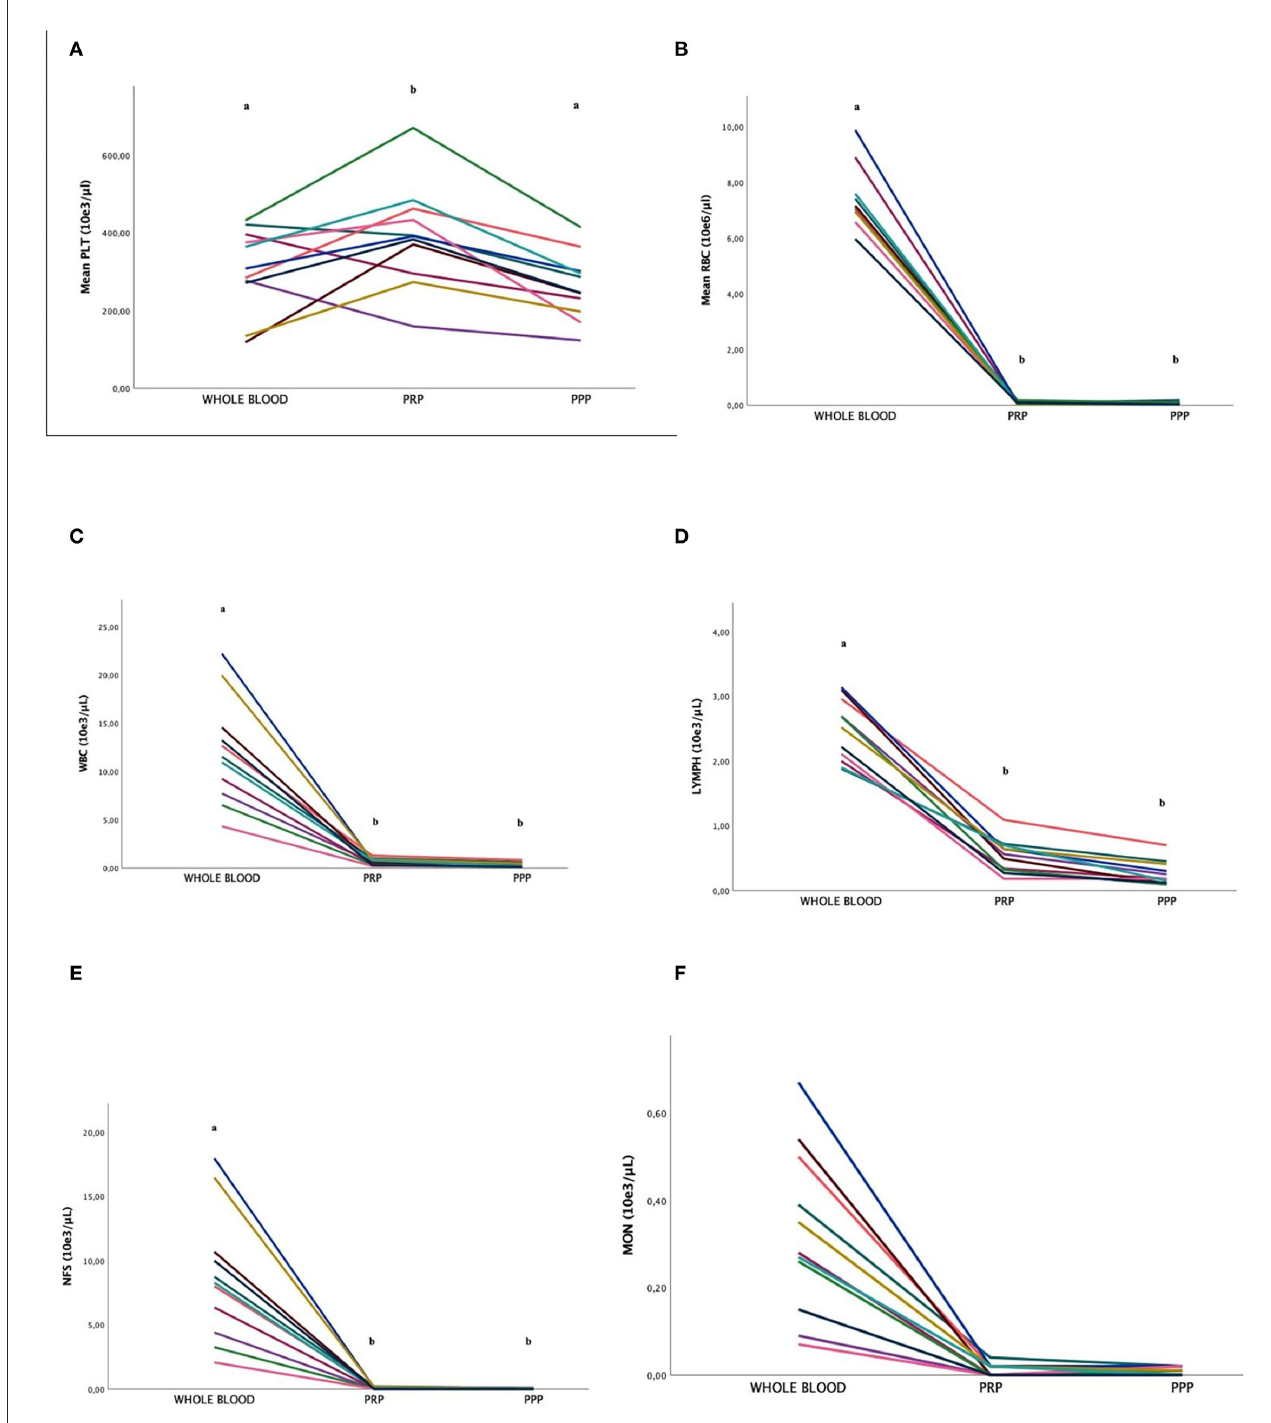
FIGURE2 Comparison of the platelet [PLT; (A) ], red blood cell [RBC; (B) ], white blood cell [WBC; (C) ], lymphocytes [LYMPH; (D) ], neutrophils [NFS; (E) ], and monocyte [MON; (F) ] concentrations (mean ± SD) in FeLV cats ( n = 11) between whole blood (WB) and PRP and PPP fractions. Different letters (a, b) indicate differences between groups. P < 0.05 statistically